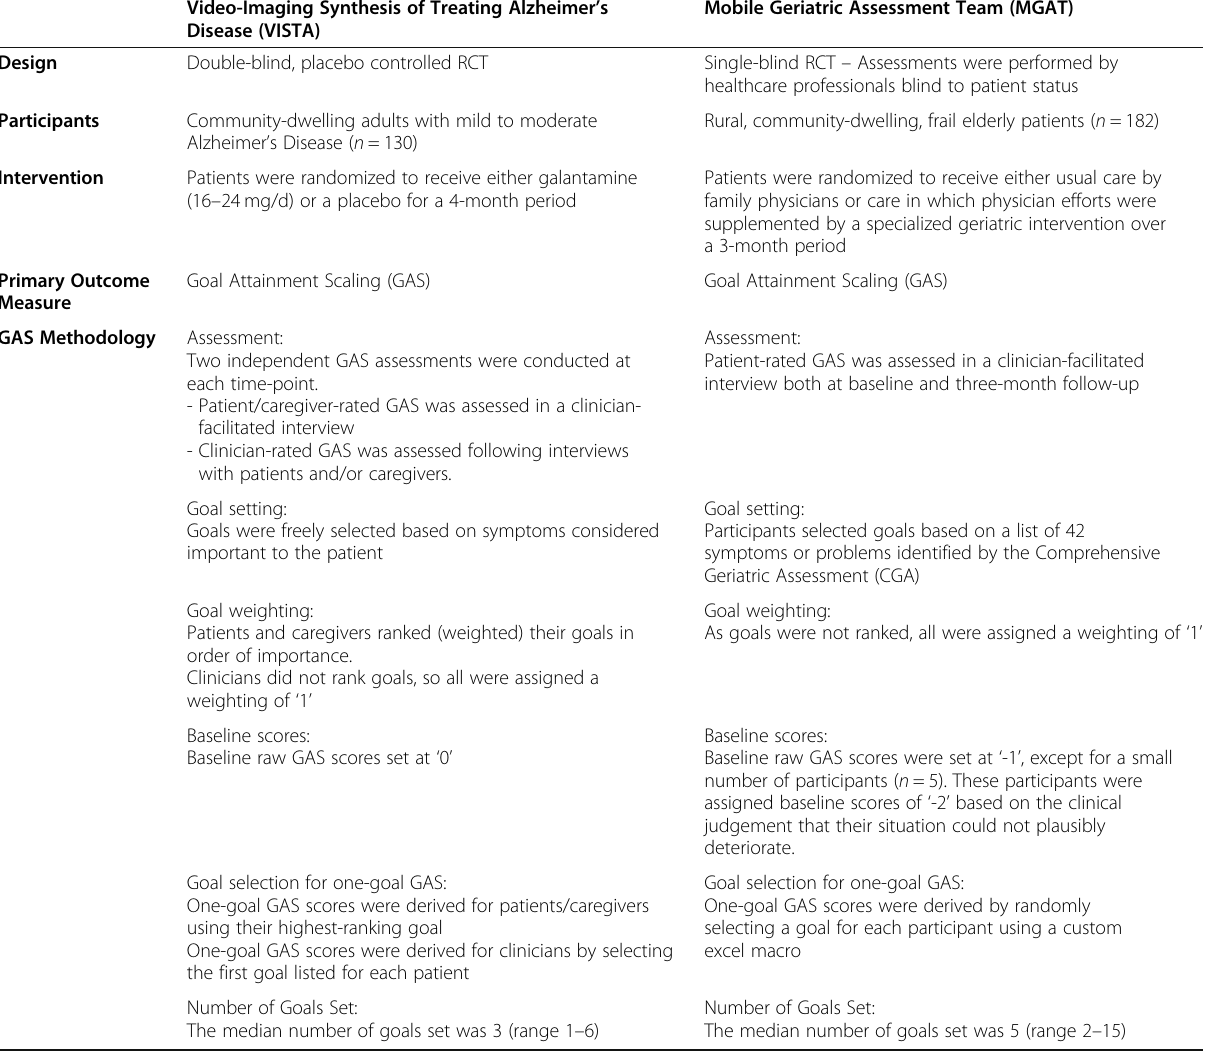
Table 1 Characteristics of the VISTA and MGAT studies